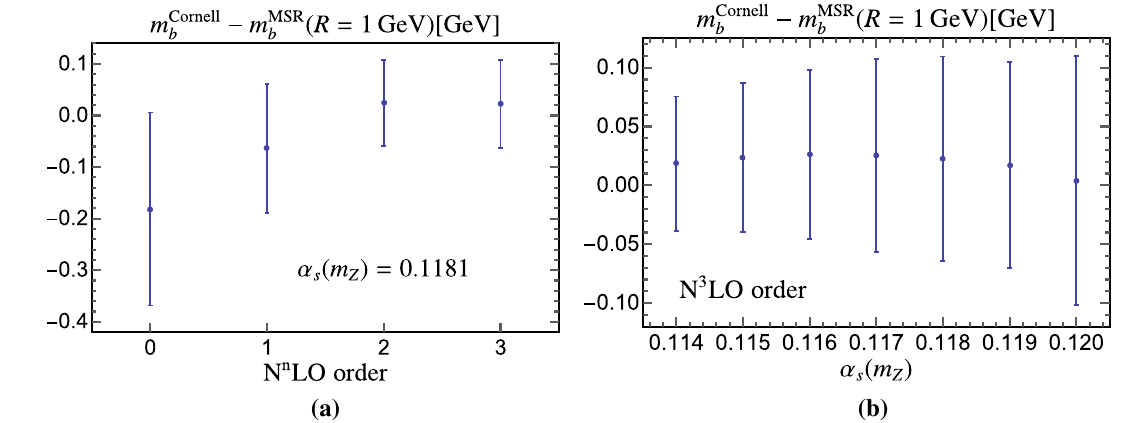
Fig. 12 Dependence of the difference between the Cornell mass parameter and the MSR mass at the reference scale R = 1GeV on a the perturbative order and b the value of the strong coupling constant